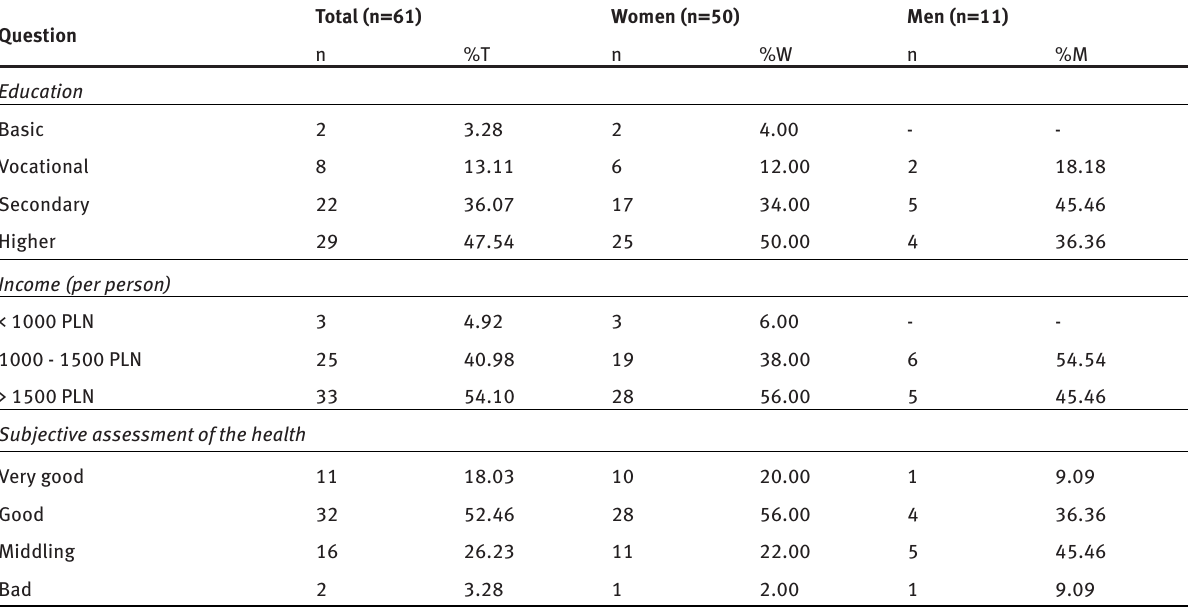
Table 3: Socio-economic status and subjective assessment of the health of the students